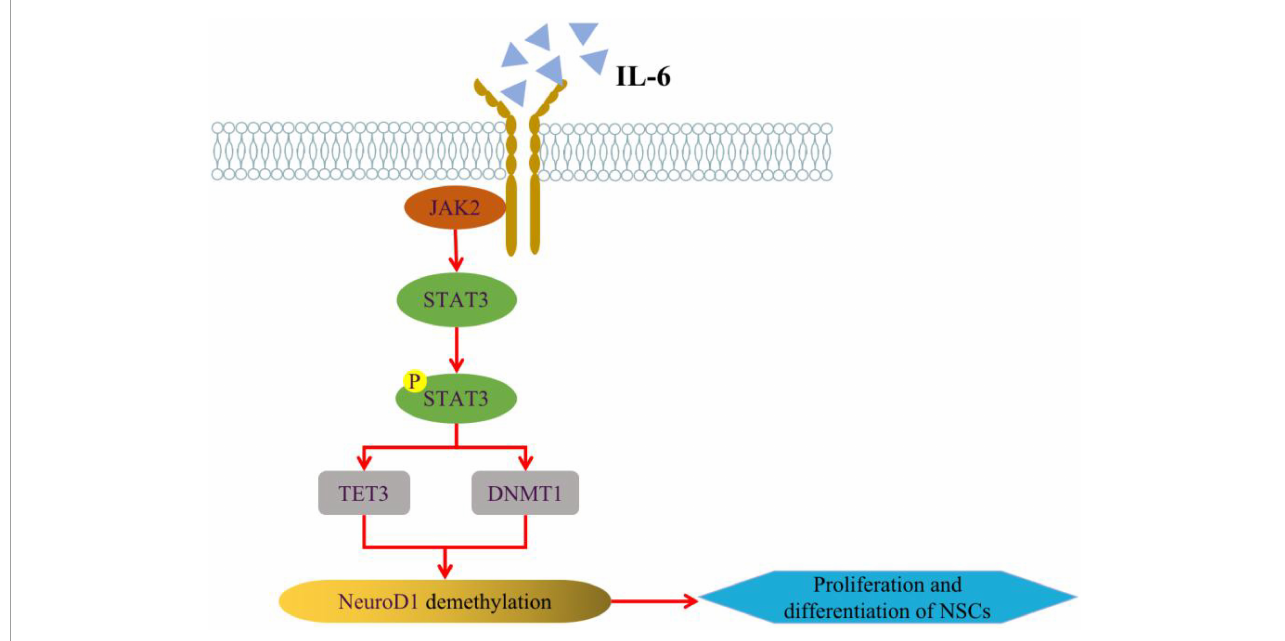
FIGURE2 Regulation of IL-6/JAK2/STAT3 pathway on AHN. IL-6 can alter the expression of TET3 and DNMT1 in NSCs through JAK2/STAT3 signaling pathway, thus enhancing the expression of NeuroD1 (Neurogenic differentiation 1) gene through active or passive DNA demethylation, and regulating NSCs neurogenesis at the epigenetic level. Some of this illustration was started from a Scidraw